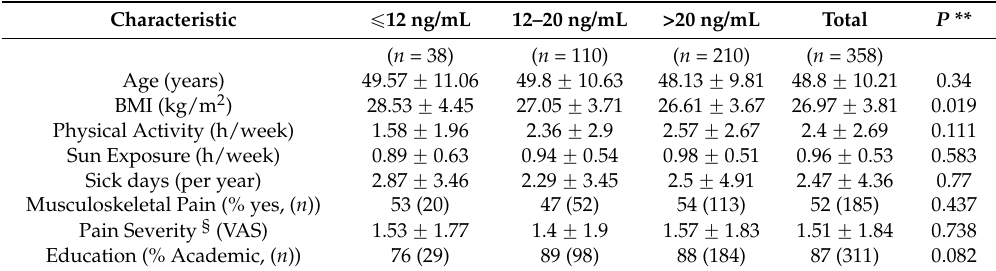
Table 1. Characteristics of the study population across 25(OH)D (ng/mL) levels.